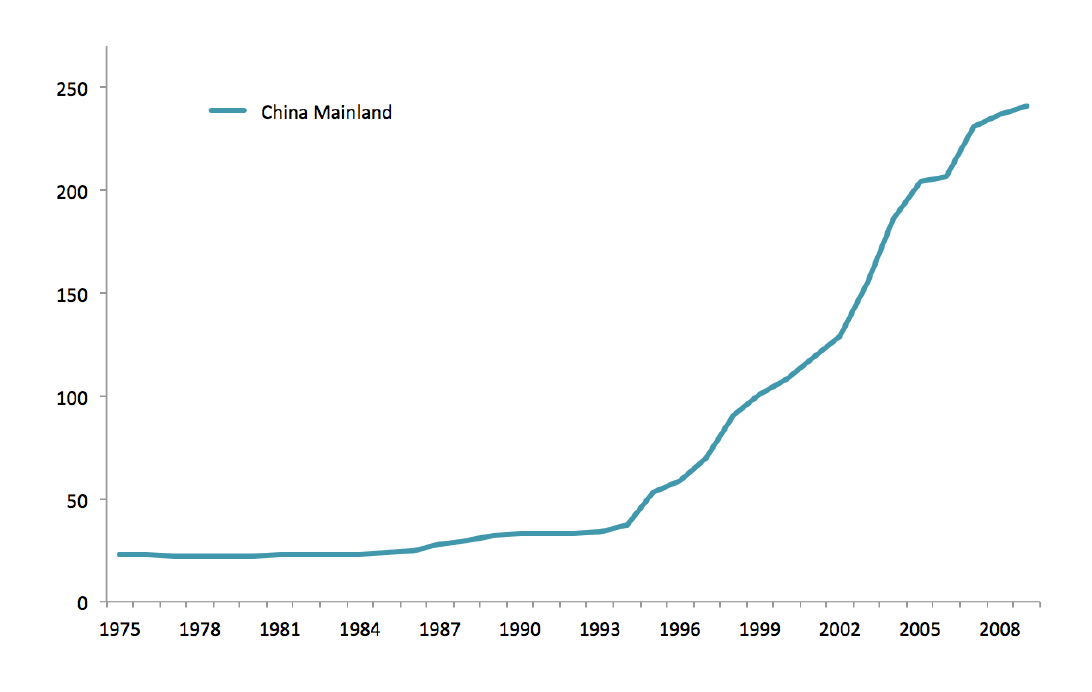
Figure 5: New Business Registrations in Hong Kong from Mainland